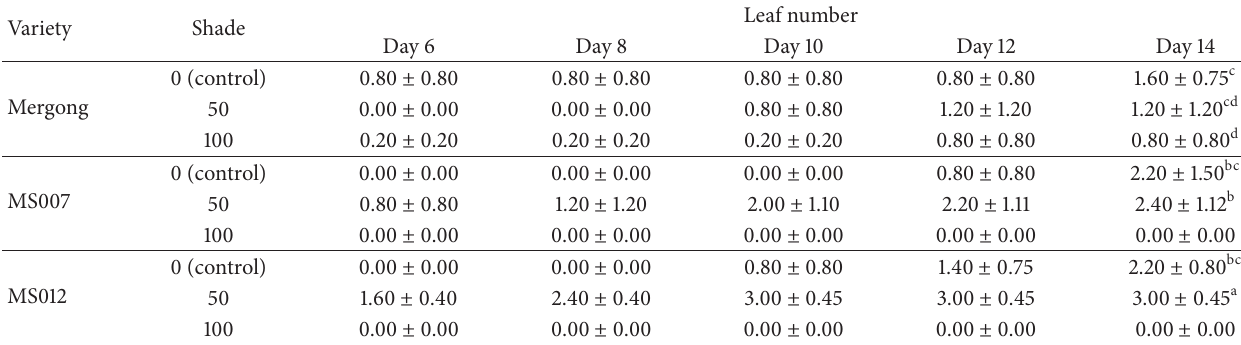
Table 15: Mean leaf number of three varieties treated with 50% and 100% shade treatments from day 6 to day 14.